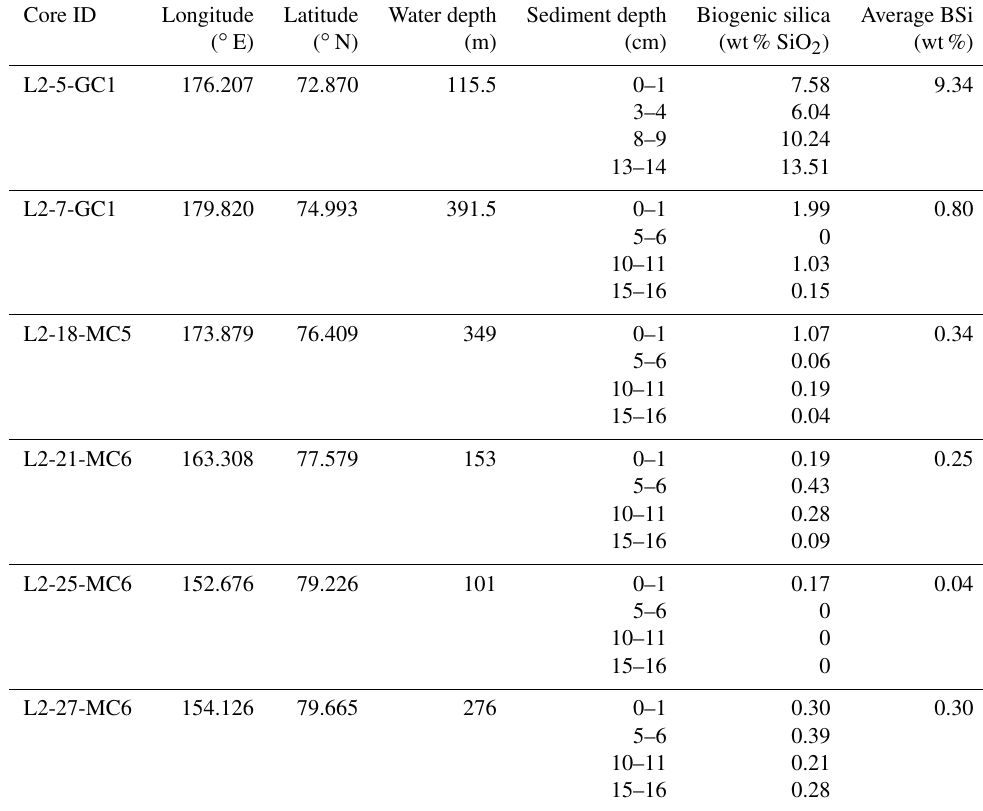
Table 1. Geographic information of sediment cores and their biogenic silica